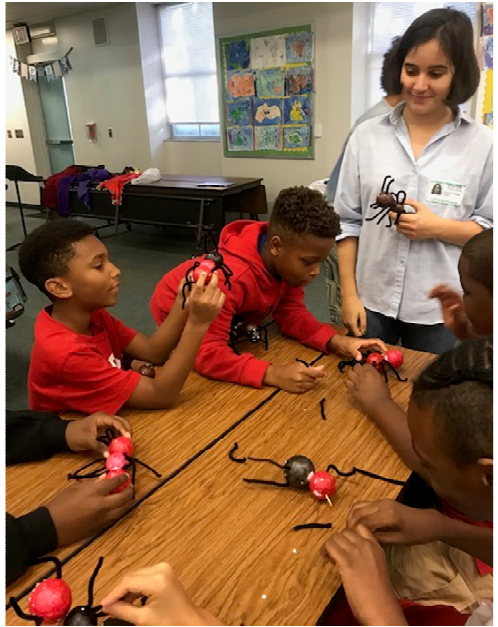
Figure 2. Fifth graders building ants. Picture by M.S.